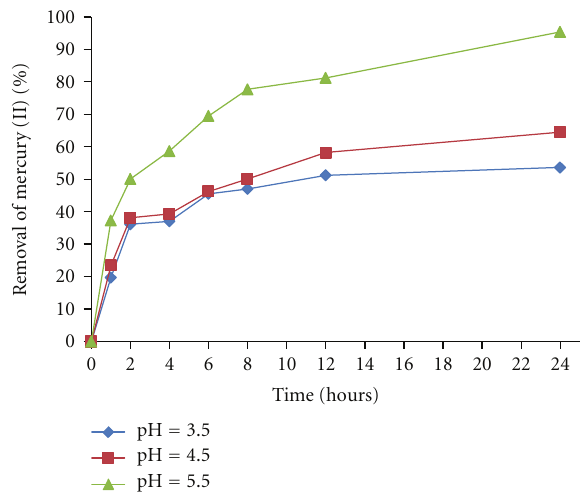
Figure 1: The e ff ect of pH and incubation time on the biosorption of mercury (II). 100 mg/L Hg (II), 30 ◦ C, 100 rpm, 1 g of fungal biomass of M. rouxii